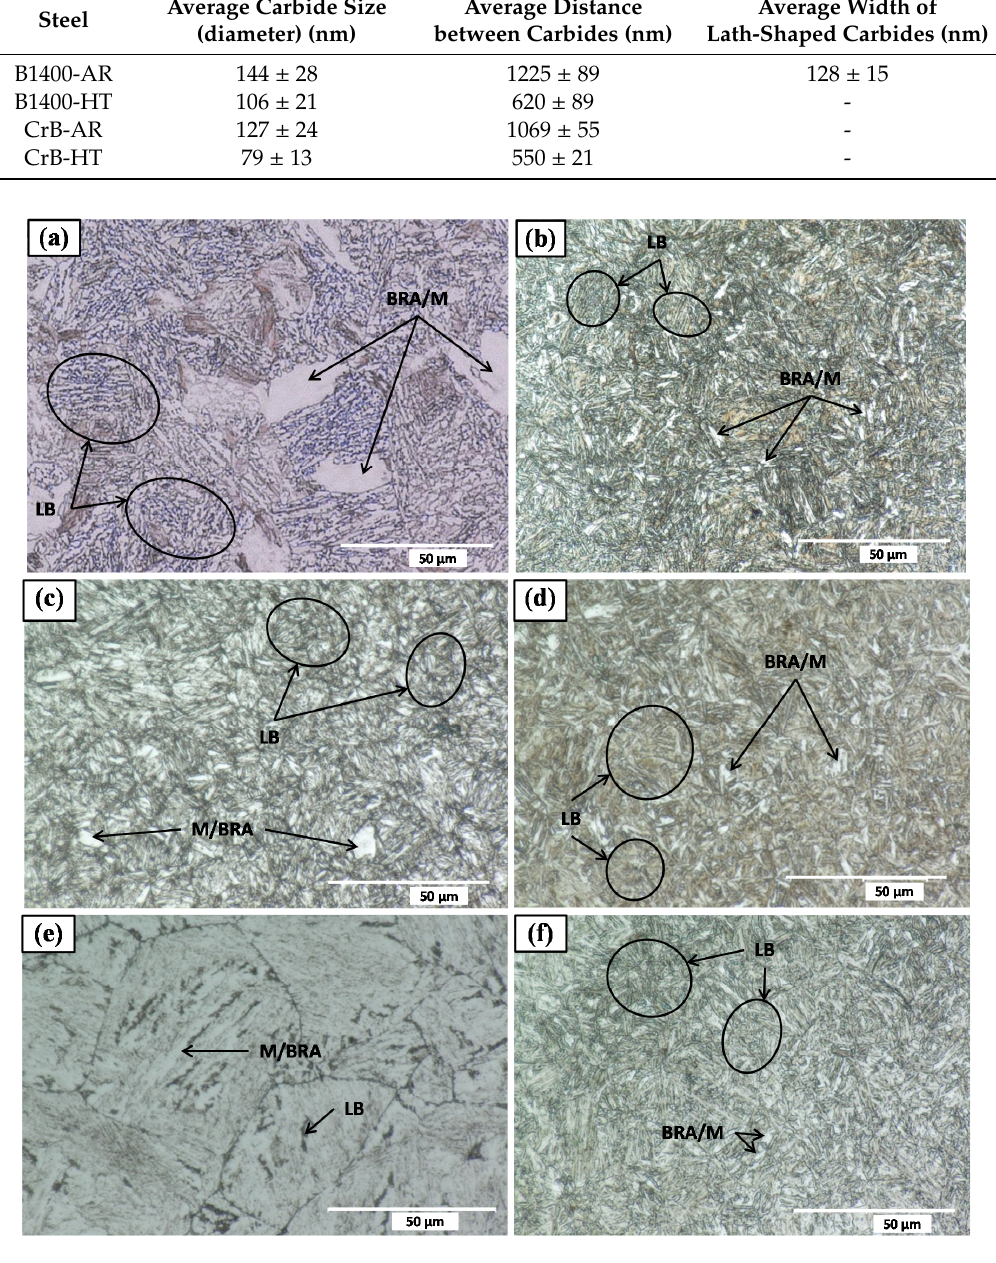
Figure 7. Light optical microscopy LOM images of all bainitic steels; ( a ) B360-AR, ( b ) B360-HT, ( c ) B1400-AR and ( d ) B1400-HT, ( e ) CrB-AR, ( f ) CrB-HT.